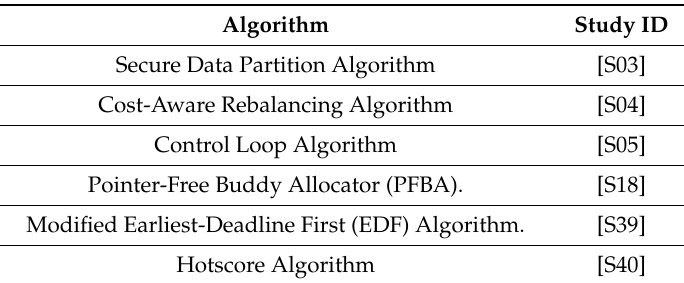
Table 7. Algorithms used in selected